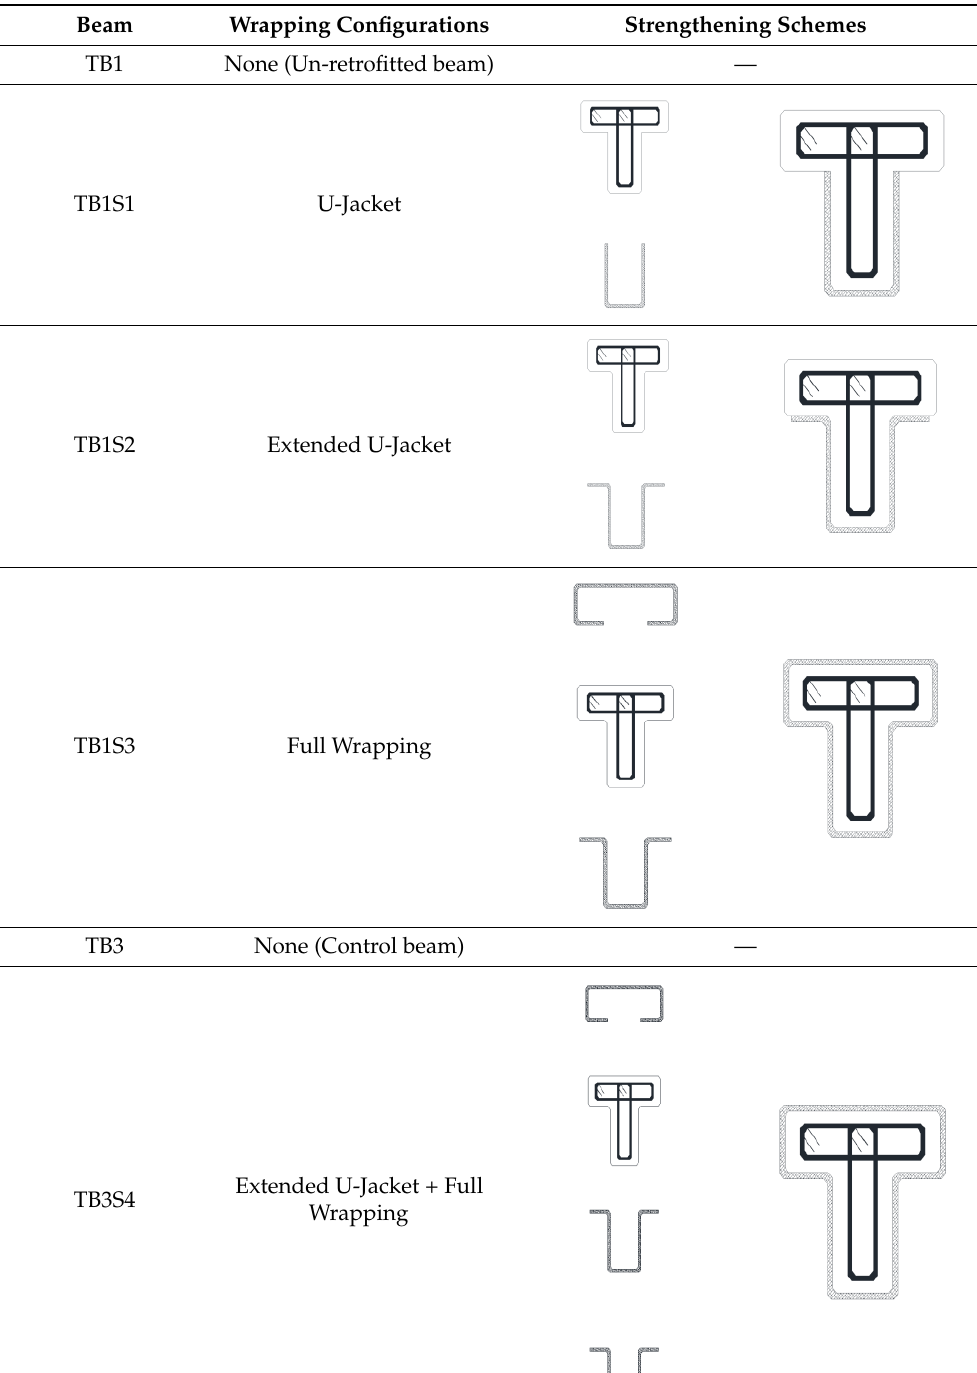
Table 1. Strengthening wrapping configuration.